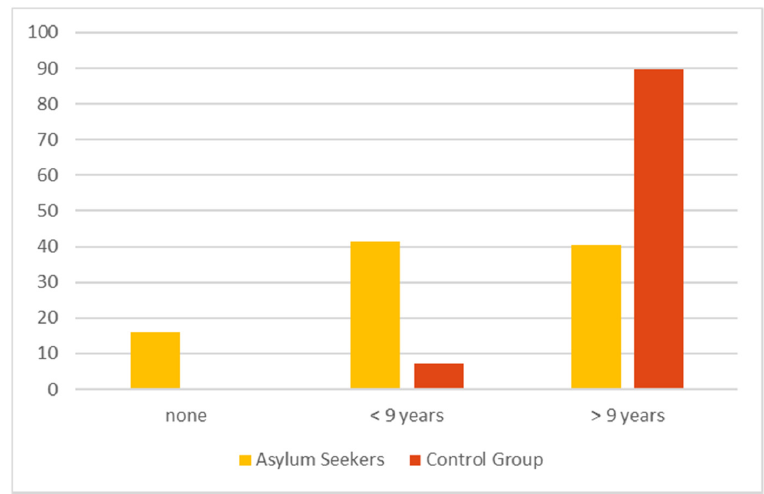
Figure 1. Formal education (years in school), numbers in % (missing answers: asylum seeker (AS) 2, control group (CG) 2).